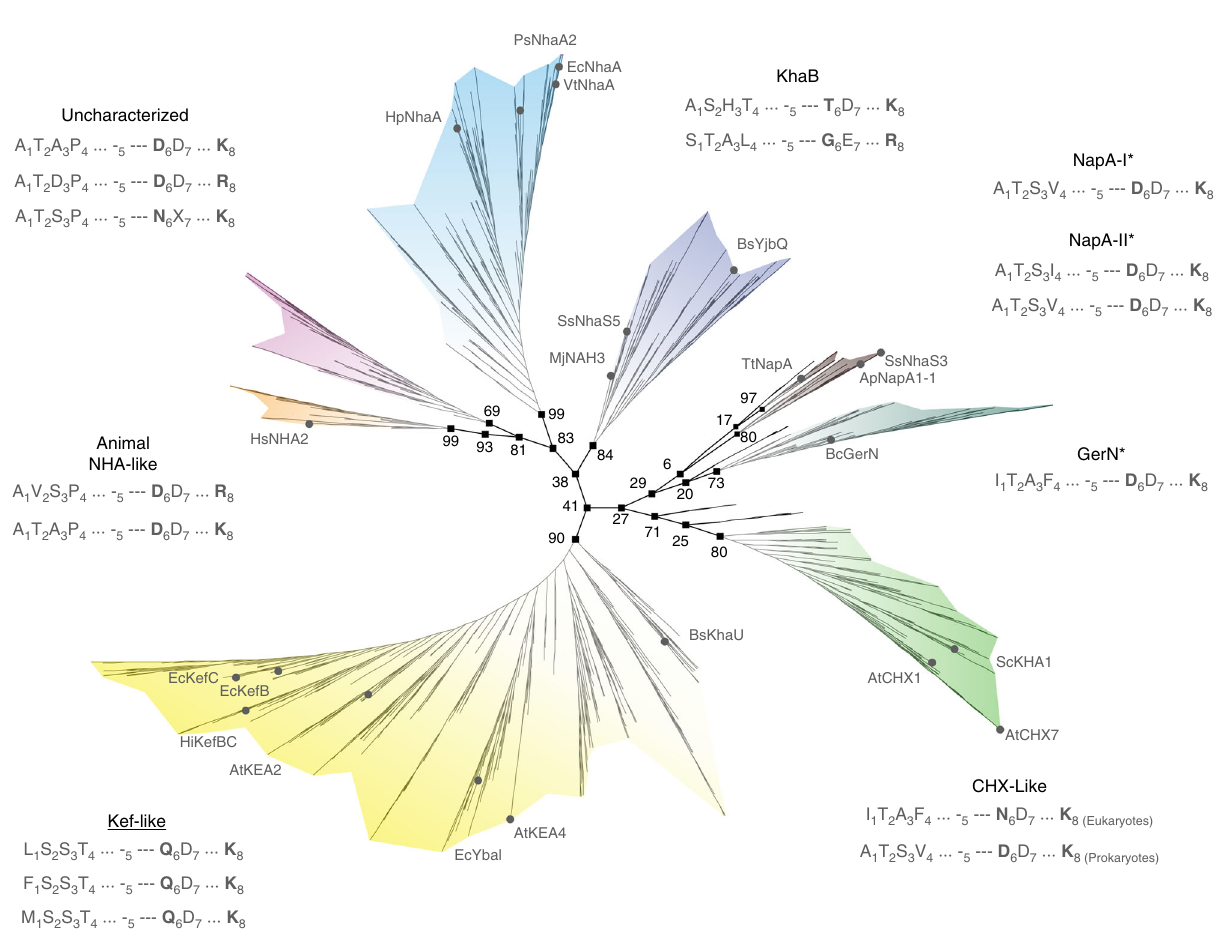
Fig. 2 The CPA2 subtree. Unrooted tree with the main clades highlighted in different colors and the prevalent motifs that correlate with each clade listed as in Fig. 1. The names of K + -selective clades are underlined; whereas. the names of known electrogenic clades and sub-clades are marked with an asterisk. Bootstrap values are marked for the branches that separate the main clades. Names of representative CPAs are presented at the